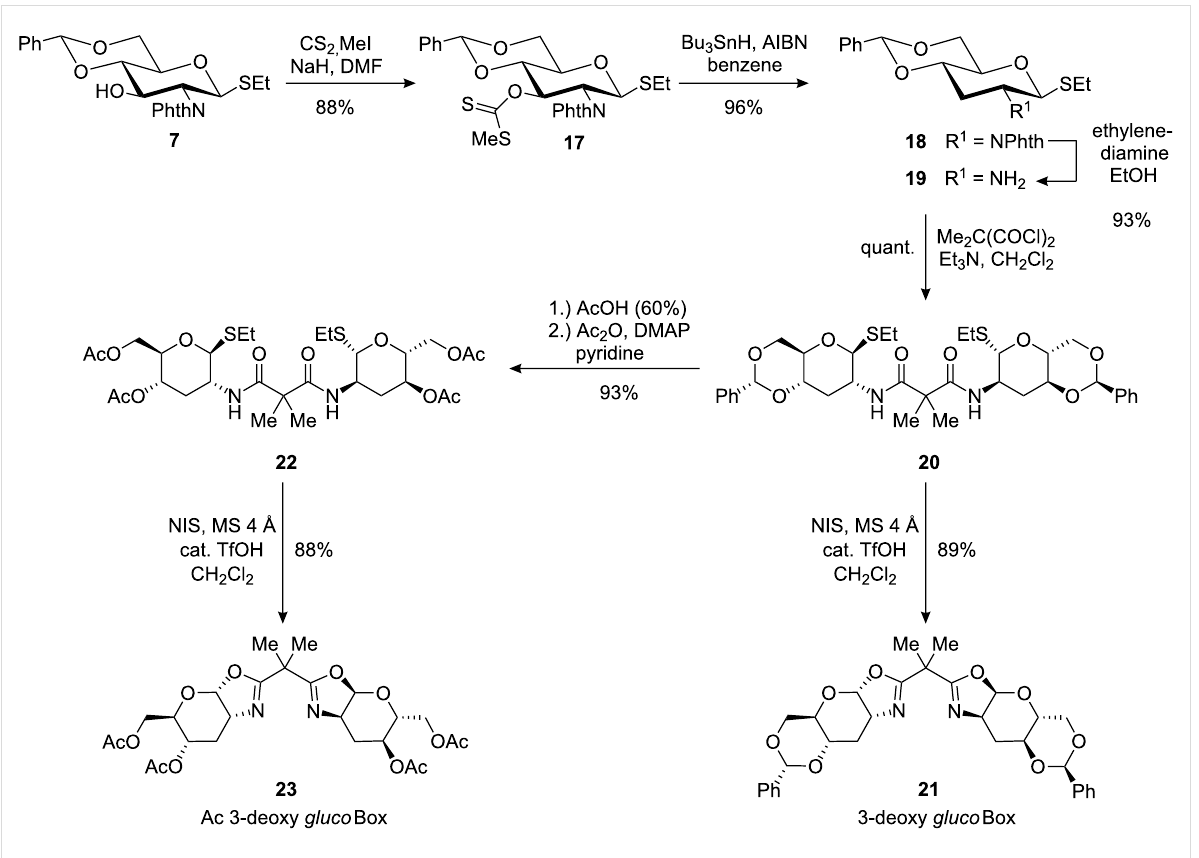
Scheme 3: Preparation of ligands 3-deoxy gluco Box ( 21 ) and Ac 3-deoxy gluco Box ( 23 ) from key intermediate 7